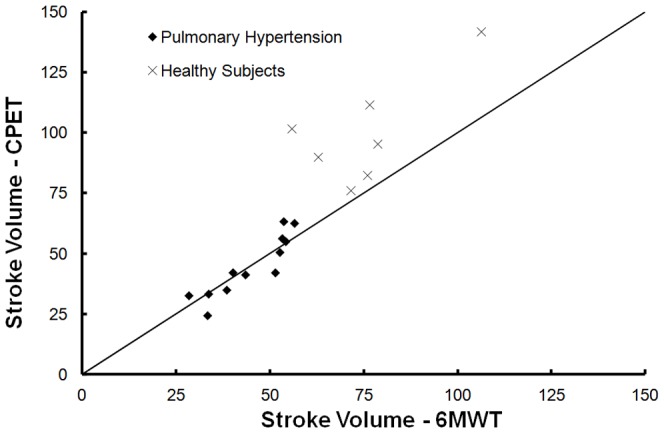
Stroke volume calculated directly after the end of a 6MWT and of a CPET in 12 pulmonary hypertension patients and 7 healthy subjects.(-) Line of identity (where SV6MWT = SVCPET).